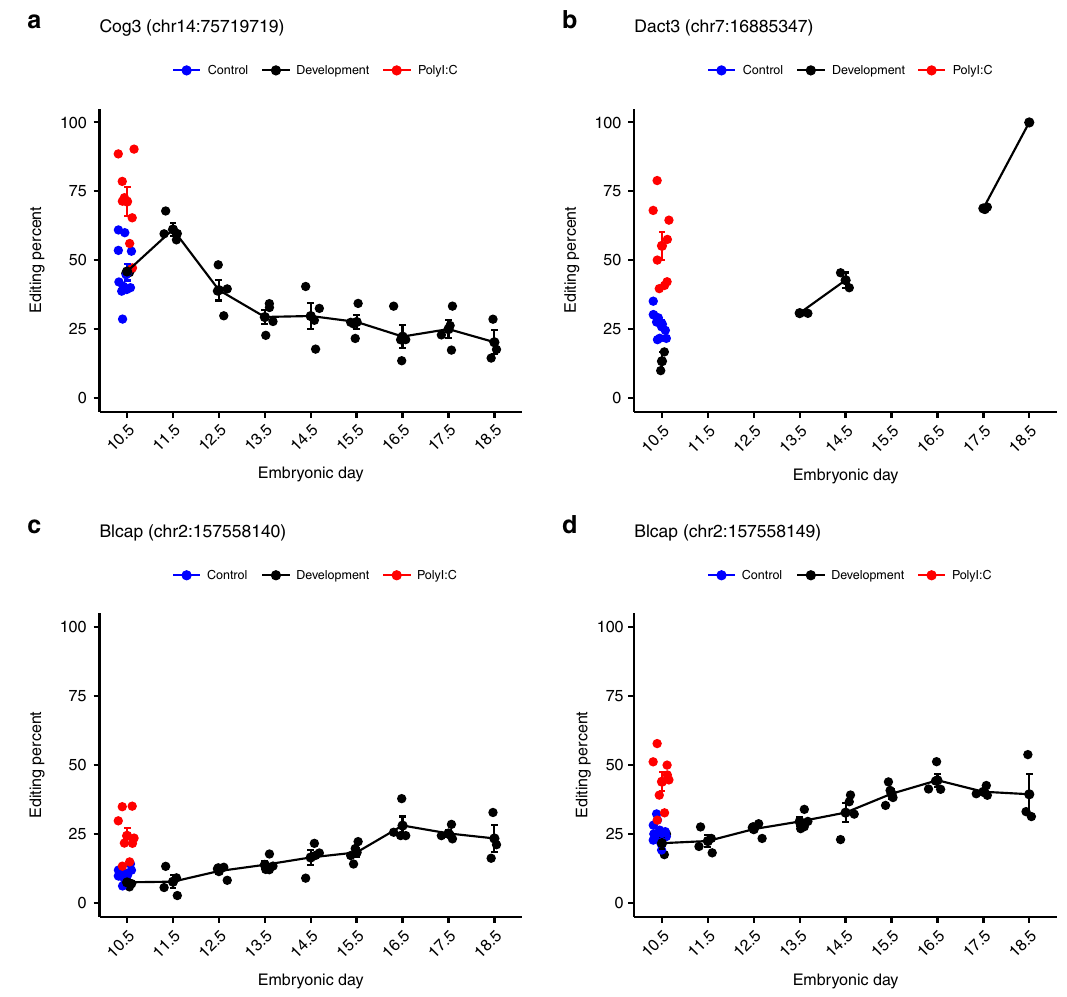
Fig. 5 Reproducible pattern of RNA editing levels in embryonic mouse brain development. A-to-I RNA editing levels in evolutionary conserved coding editing sites in the brains of healthy mouse embryos during brain development ( n = 4 for days 11.5 – 17.5, n = 3 for days 10.5 and 18.5). Levels of RNA editing from PolyI:C ( n = 8) and control ( n = 11) mice from the MIA model are indicated on GD10 when the brains were sequenced. The top four recoding editing sites that showed the largest change in editing levels in the MIA model are a COG3 (chr14:75719719), b DACT3 (chr7:16885347), c BLCAP (chr2:157558110), and d BLCAP (chr2:157558140). Editing level is indicated only when suf fi ciently expressed (see “ Methods ” ). All values are means ± SEM. Source data are provided as a Source Data fi